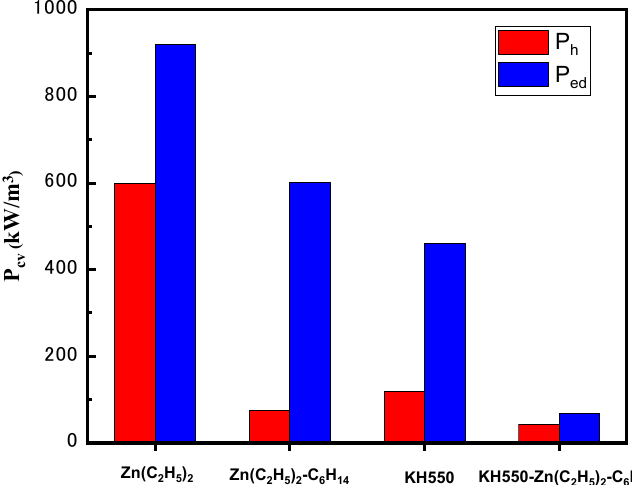
Figure 4. Separation of iron loss for samples prepared by different surface treatments at f = 100 kHz and B = 20 mT.